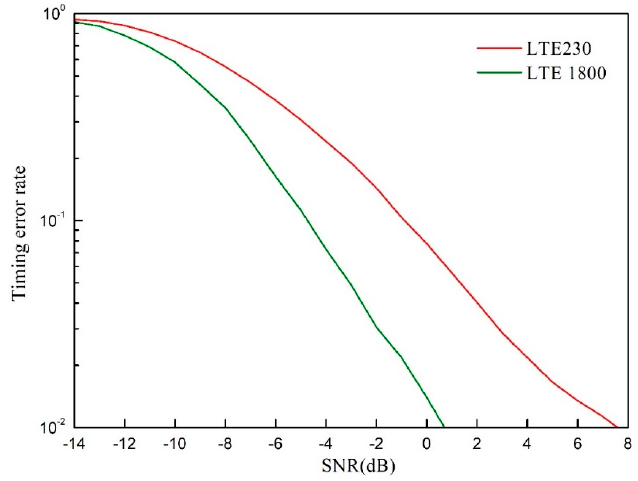
Figure 9. Performance comparison of the timing performance between LTE 1800 and LTE 230.